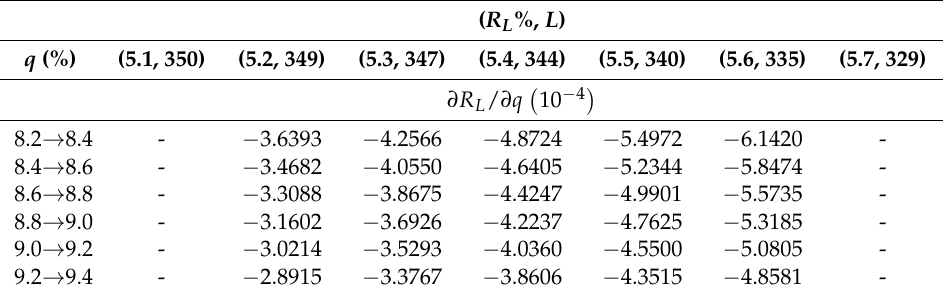
Table 4. Responsiveness of bank interest margin to capital-to-deposits ratio 1